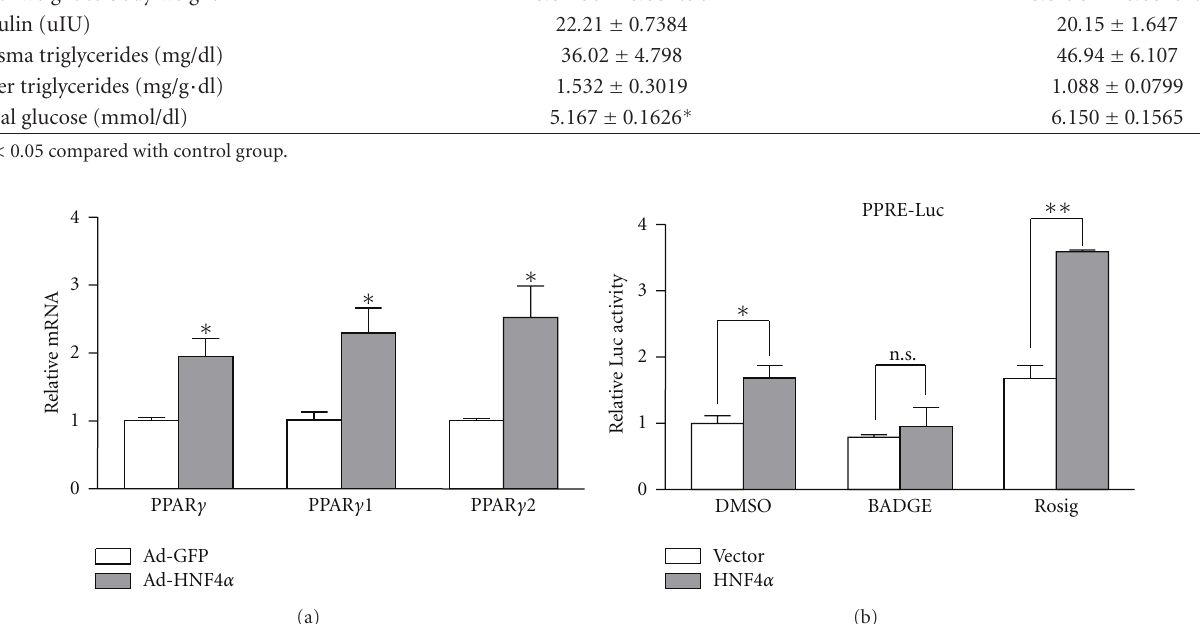
Figure 1: Hepatic nuclear factor 4 α (HNF4 α ) induced peroxisome proliferator-activated receptor γ (PPAR γ ) transcription activity in hepatocytes. (a) Quantitative RT-PCR (qRT-PCR) analysis of mRNA levels of PPAR γ and its subtypes PPAR γ 1 and PPAR γ 2 in isolated primary hepatocytes. (b) HepG2 cells were cotransfected with plasmids of 3 × PPRE-Luc reporter plasmid with pMT7-HNF4 α or vehicle plasmid for 24 hr, and luciferase activity with PPAR γ antagonist BADGE and agonist rosiglitazone (Rosig) was measured. The β -gal plasmid was cotransfected as a transfection control. Promoter activities were measured by relative luciferase activity, which was normalized to that of β -gal. Results are mean ± SEM mRNA levels normalized to that of β -actin and expressed as fold of control group (DMSO). Results are representative of 3 independent experiments. ∗ P < 0 . 05, ∗∗ P < 0 .